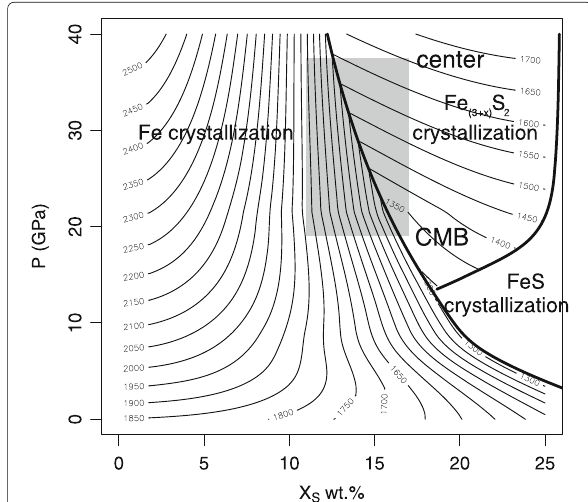
Fig. 3 Melting relations in the Fe-FeS system in the pressure and compositional range suitable for Mars’ core. Isotherms show temperature (K) of appearance of first solid in the system depending on the composition and pressure. Thick lines delimit fields of first crystallizing solid: Fe, FeS, and Fe 3 − x S 2 (Fe-FeS eutectic on left and incongruent melting of Fe 3 − x S 2 on right). Gray box shows likely pressure and compositional range for core. Intersection of box with isotherms shows that for any crystallization of solids in the inner core, temperatures must be less than ∼ 1650 K. First solids to crystallize will be Fe 3 − x S 2 if in S-rich compositions and will be Fe if S-poor. When eutectic reached, crystallizing solids will vary depending on